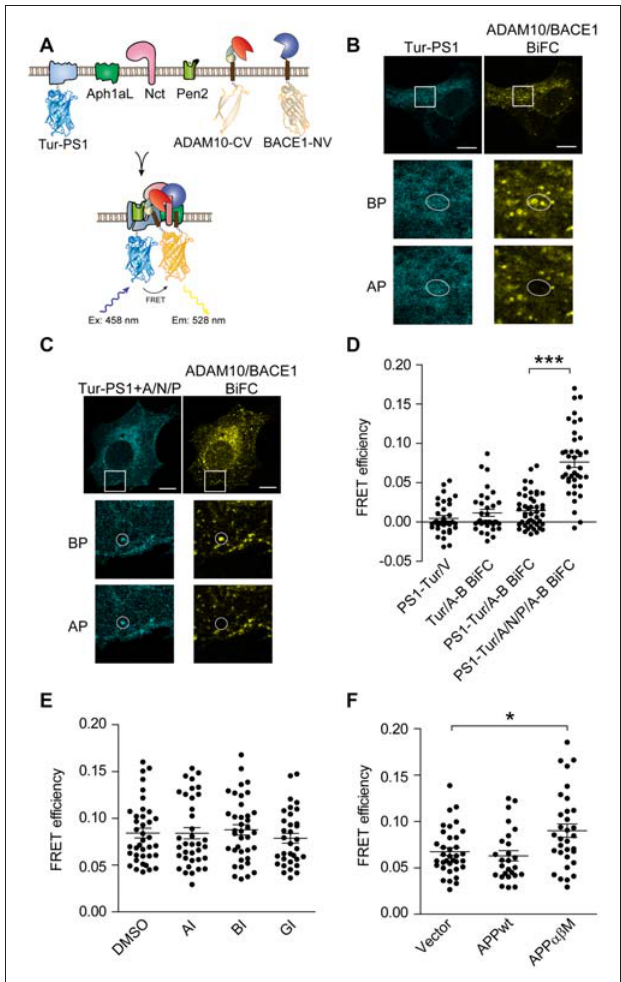
FIGURE 3 | Visualization of APP/ α -/ β -secretase ternary complex using BiFC-fluorescence resonance energy transfer (FRET). (A) Schematic for ADAM10-CV, BACE1-NV and APP-mTurquoise2 (APP-Tur) constructs. mTurquoise2 were fused to the C-terminal of APPwt. (B,C) Representative images of APP/ADAM10/BACE1 BiFC-FRET analysis in (D) . Scale bar: 10 µ m. HEK 293 cells were transfected with ADAM10-CV, BACE1-NV and APP-Tur for 12 h, and treated with DMSO (B) or 3 µ M GI254023X and 1 µ M BSI-IV (C) for 4 h before fixation. (D) FRET analysis between APP-Tur and ADAM10/BACE1 BiFC particles. HEK 293 cells were transfected with designated plasmids for 16 h, and fixed for FRET analysis. AI: treated with 3 µ M α -secretase inhibitor GI254023X, BI: treated with 1 µ M β -secretase inhibitor BSI-IV for 4 h. BP: before photobleach, AP: after photobleach. N = 28–46 per condition. A one-way ANOVA with Bonferroni’s multiple comparisons was used. ∗∗∗ p < 0.001. (E) FRET analysis between APP-Tur and ADAM10/BACE1 BiFC particles in differentiated neuro-2a cells. Neuro-2a cells were transfected for 16 h followed by treatment with GI254023X and BSI-IV for 8 h, and fixed for FRET analysis. Scale bar: 20 µ m. (F) Quantification of FRET analysis in (E) . N = 19–26 per condition. A one-way ANOVA with Bonferroni’s multiple comparisons was used. ∗∗∗ p < 0.001.